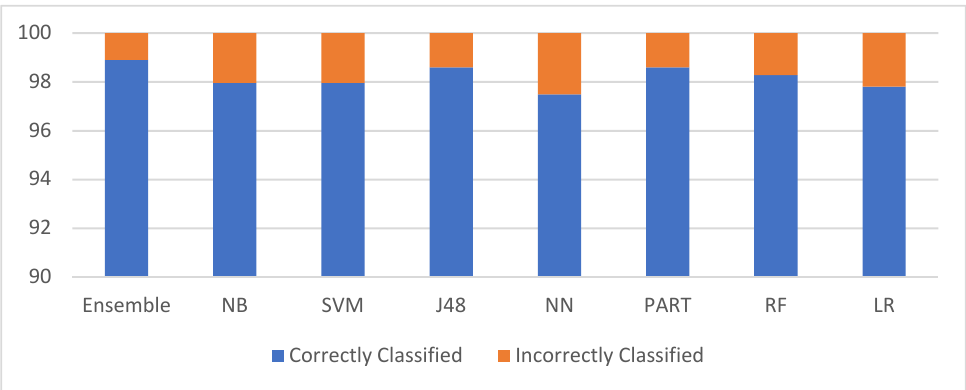
Figure 2. Performance of ensemble model against traditional classifiers.